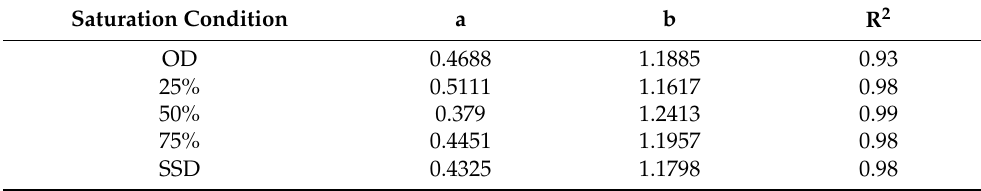
Table 5. Regression analysis parameters of the relationship between static and dynamic elastic moduli across all mixes for each saturation